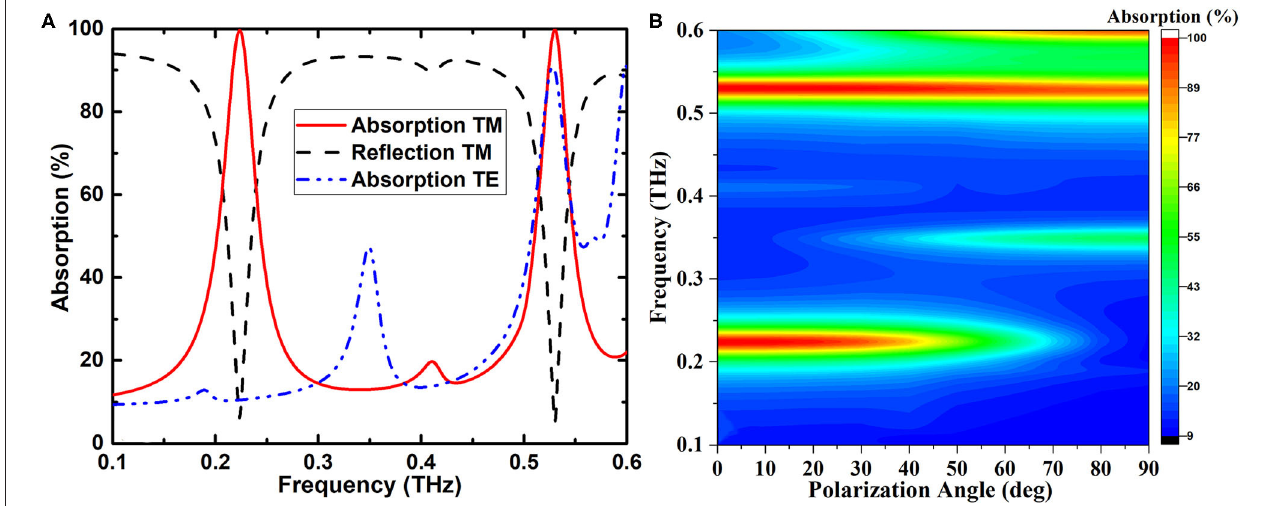
FIGURE 2 | (A) Absorption and reflection of the dual-band absorber. (B) Relationship between the absorption and the terahertz frequency with different polarization angles ϕ changing from 0 ◦ to 90 ◦